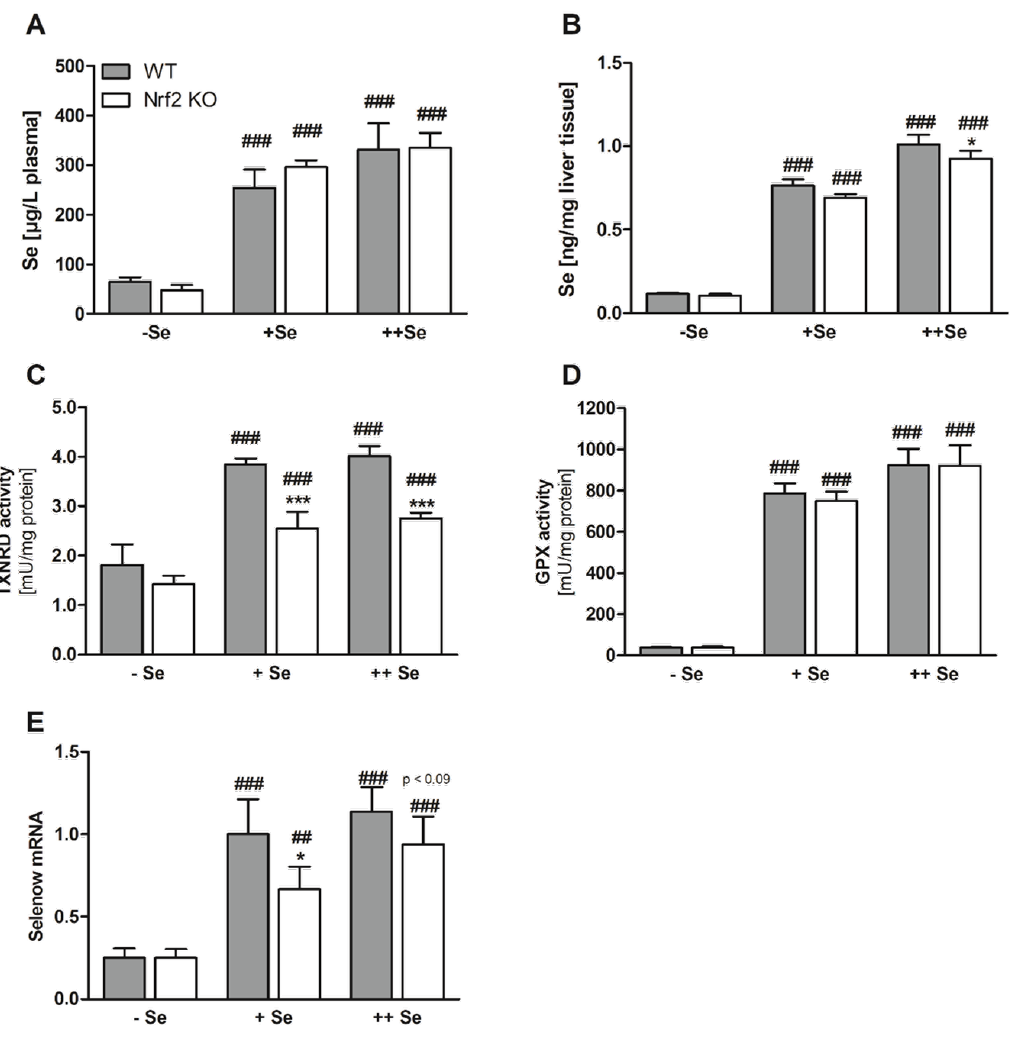
Figure 2. Biomarkers of the Se status. Se concentrations in the plasma ( A ) and liver ( B ) of Nrf2 KO and WT male mice fed diets with defined Se contents (–Se: 0.03 ppm; + Se: 0.15 ppm; ++ Se: 0.6 ppm). The TE profile was analyzed using ICP-MS / MS. Enzyme activity of TXNRD ( C ) and GPX ( D ) was analyzed together with mRNA expression of Selenow ( E ) from liver samples of male Nrf2 KO and WT mice. Bars represent means + SD ( n = 4-5). * p < 0.05; *** p < 0.001 vs. WT and # p < 0.05; ## p < 0.01; ### p < 0.001 vs. – Se (two- way ANOVA with Bonferroni’s post -test).